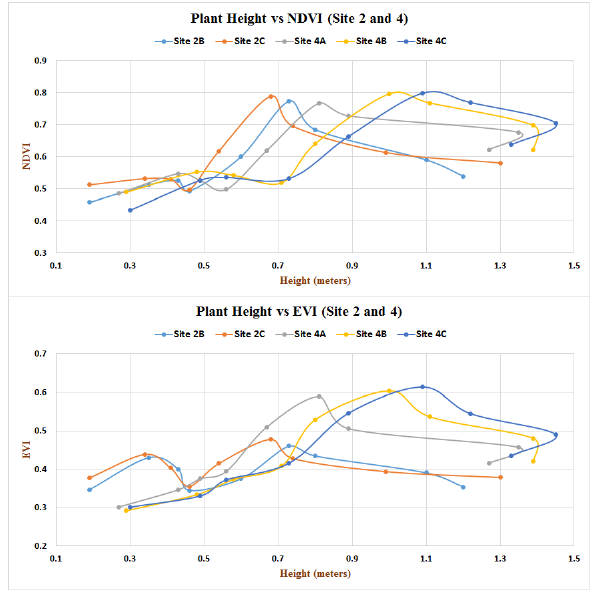
Figure 7: Graph of Rice plant height vs VI (NDVI and